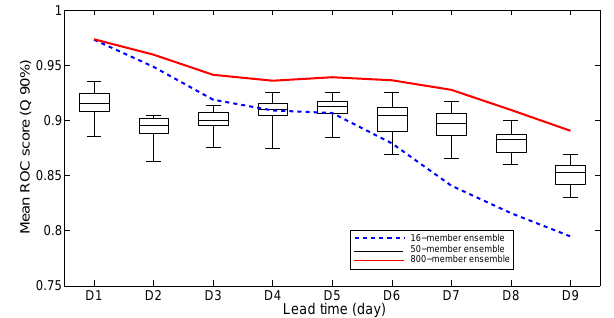
Fig. 7. Mean ROC score as a function of lead time for a flow thresh- old given by the Q90% quantile for the 29 studied catchments and three types of ensemble